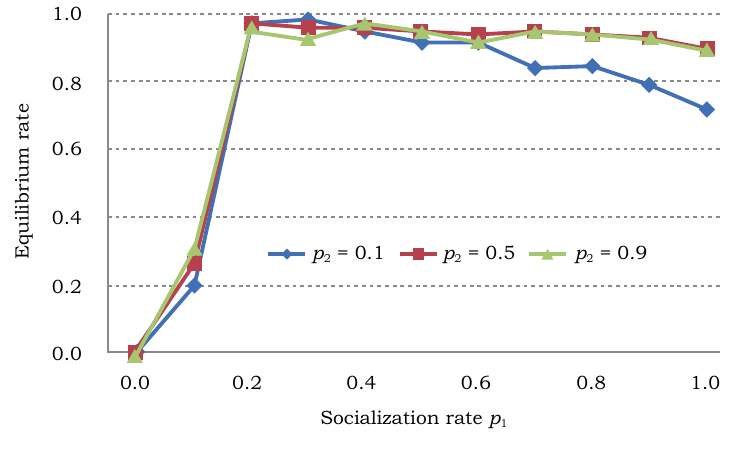
Figure 4. Equilibrium rate of March’s (1991) original